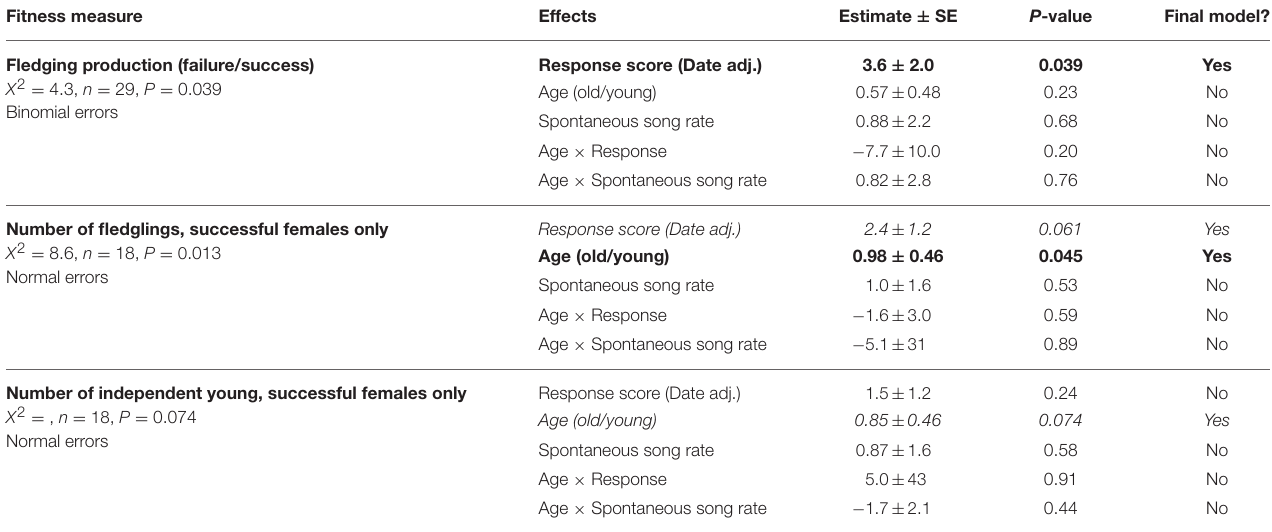
TABLE 2 | Results from generalized linear models relating fitness estimates to song